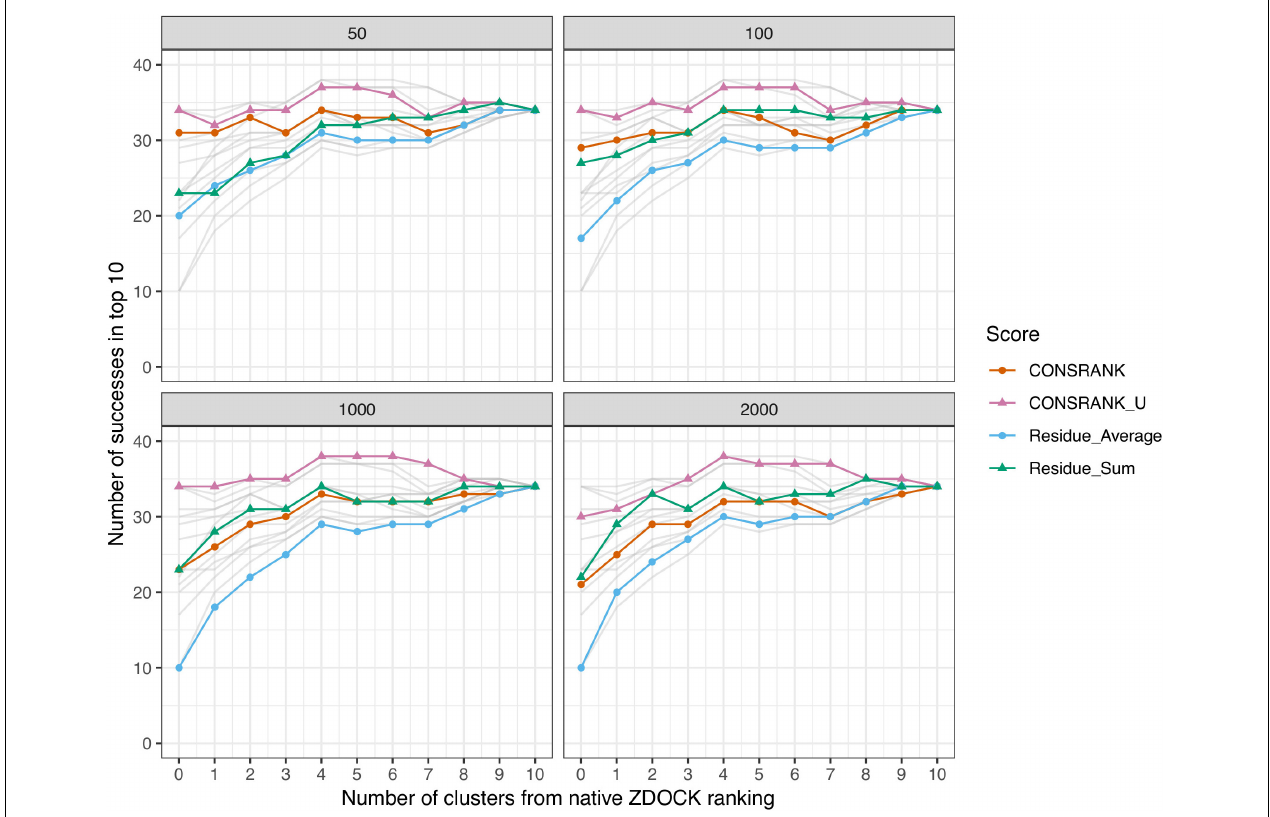
FIGURE 3 | Number of successes after combination of clusters with the ZDOCK native scoring function. Each panel corresponds to different frequency sets, i.e., sets of poses used to compute the residue and contact scores from Eqs 1 and 4. In any cases, the first 2,000 solutions of ZDOCK are rescored. Gray lines represent data from other panels for